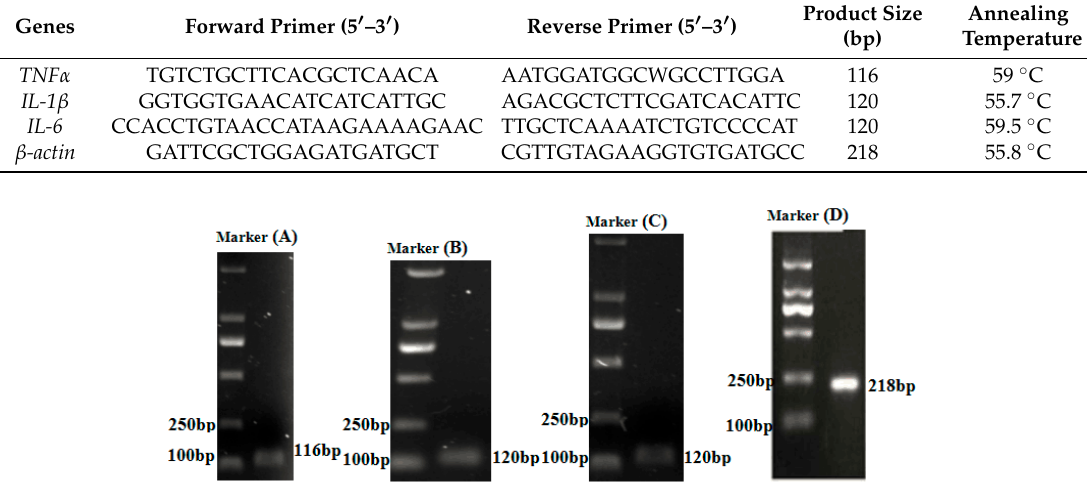
Figure 5. The amplification products of RT-PCR. Marker: DL2000, ( A ) TNF α , ( B ) IL-1 β , ( C ) IL-6 , ( D ) β -actin .